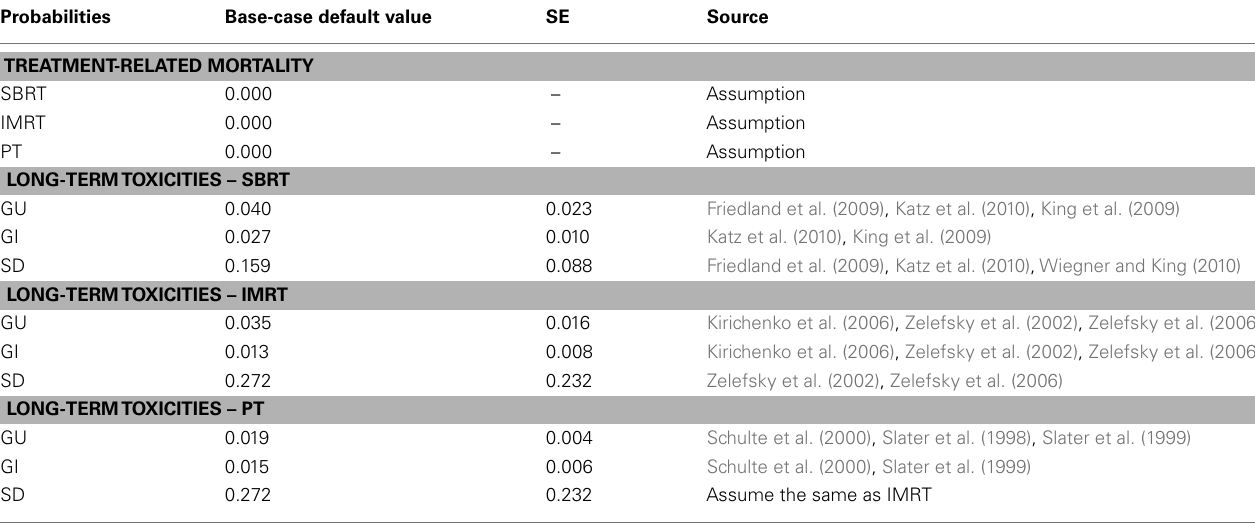
Table 2 |Treatment-related mortality and long-term